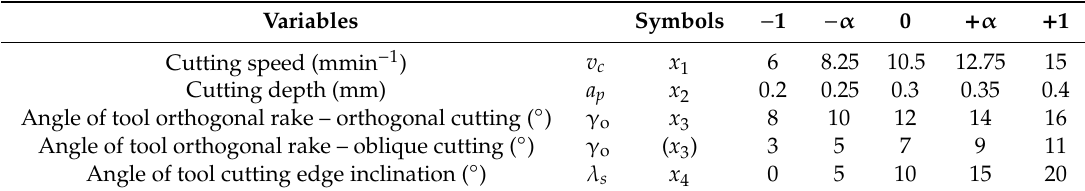
Table 5. The variables and the ranges of individual values.